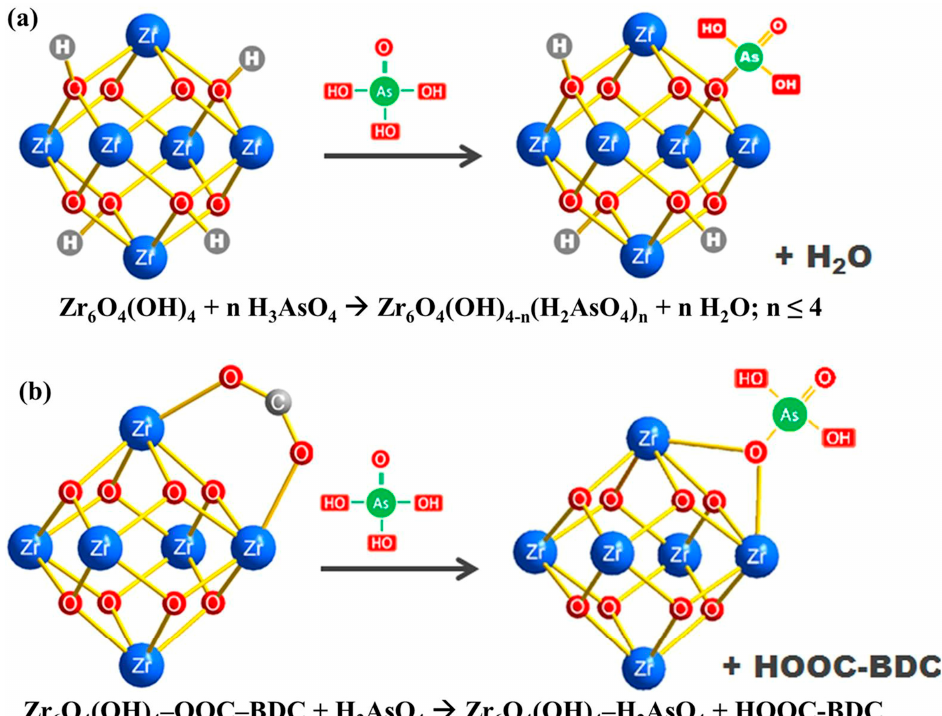
Figure 5. ( a ) Mechanism of arsenate adsorption by the hydroxyl group of UIO − 66, ( b ) Mechanism of arsenate adsorption by the BDC ligand of UIO − 66 [143]. Copyright 2015, Nature Publishing